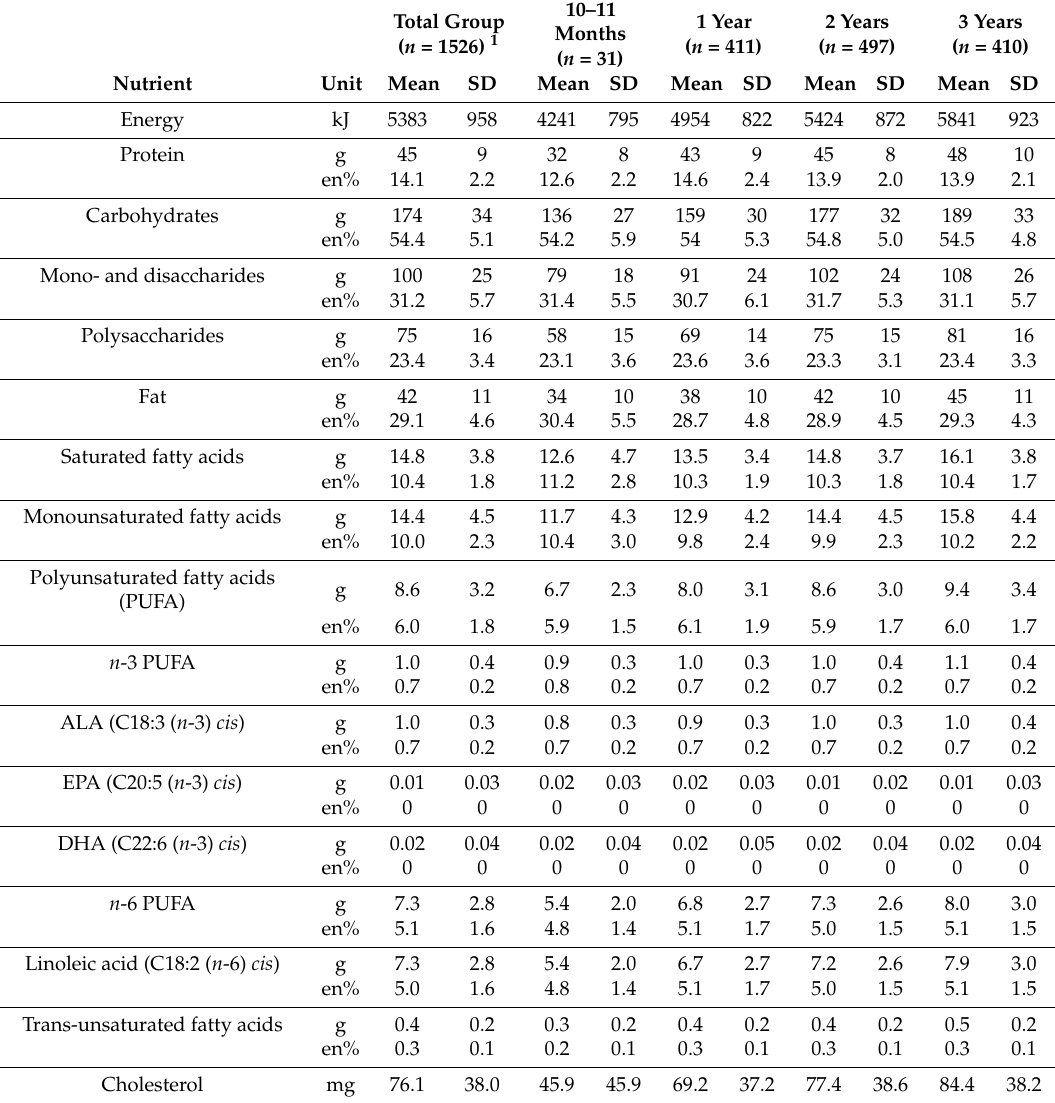
Table 2. Mean daily nutrient intake by children attending childcare by age (mean of 2